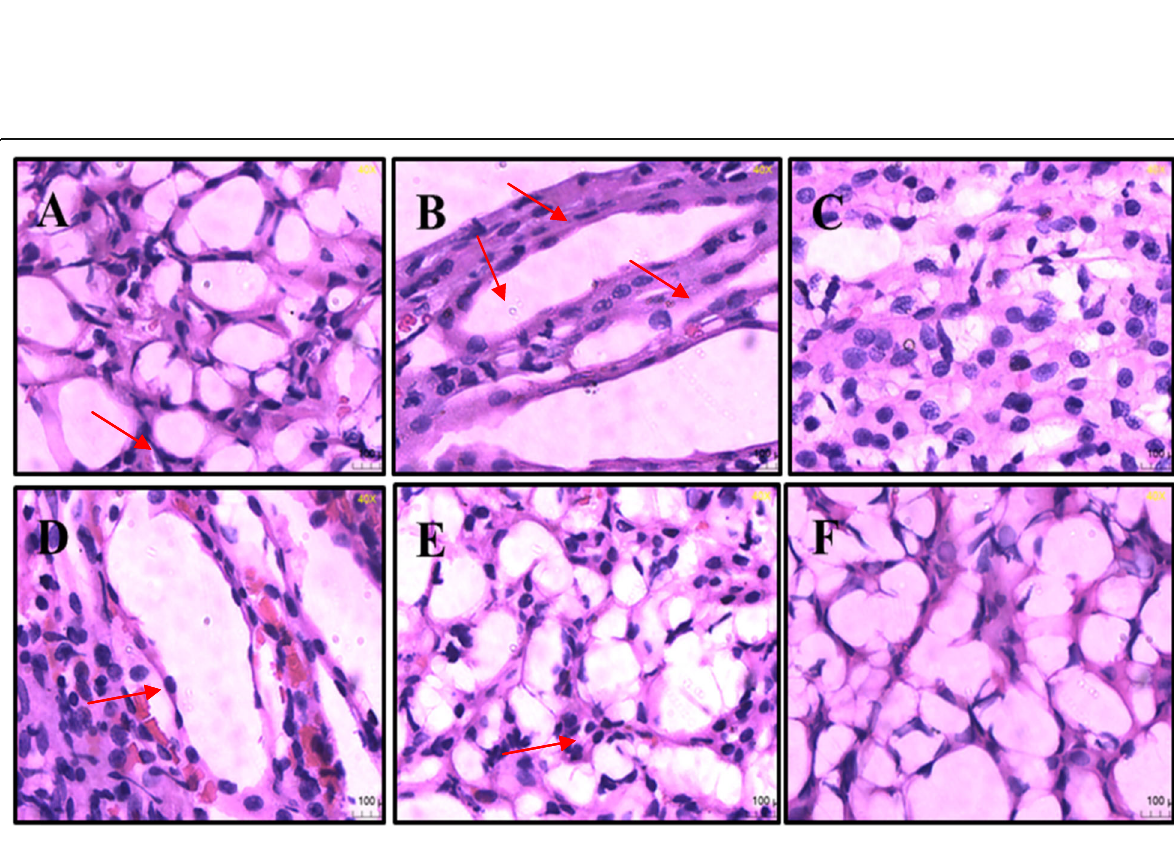
Fig. 6 Effect of STZ and formononetin on histopathological examination (sections were observed under a light microscope at magnifications of ×40). a Normal, b DN, c Met (70), d formononetin (10), e formononetin (20), f formononetin (40)